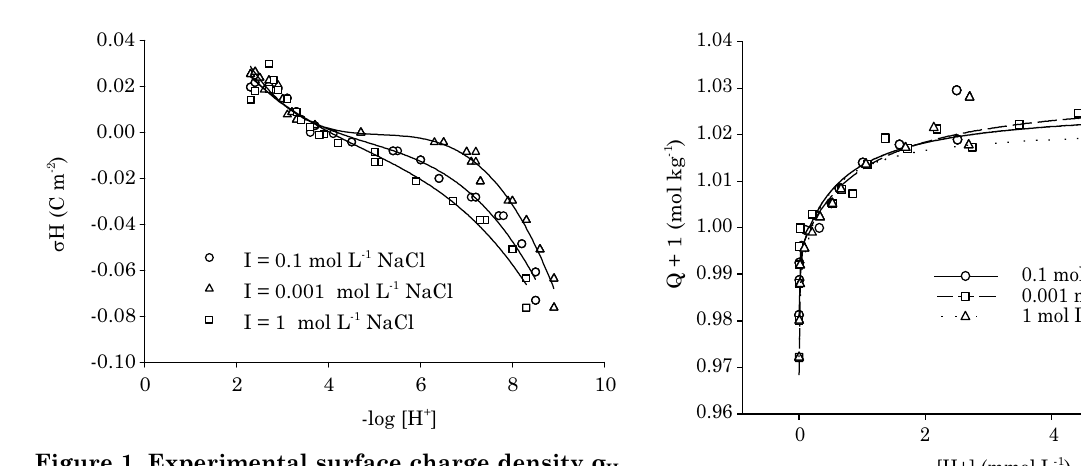
Figure 1. Experimental surface charge density σ h versus ph for an oxisol from paranavaí, pr, brazil, at three ionic